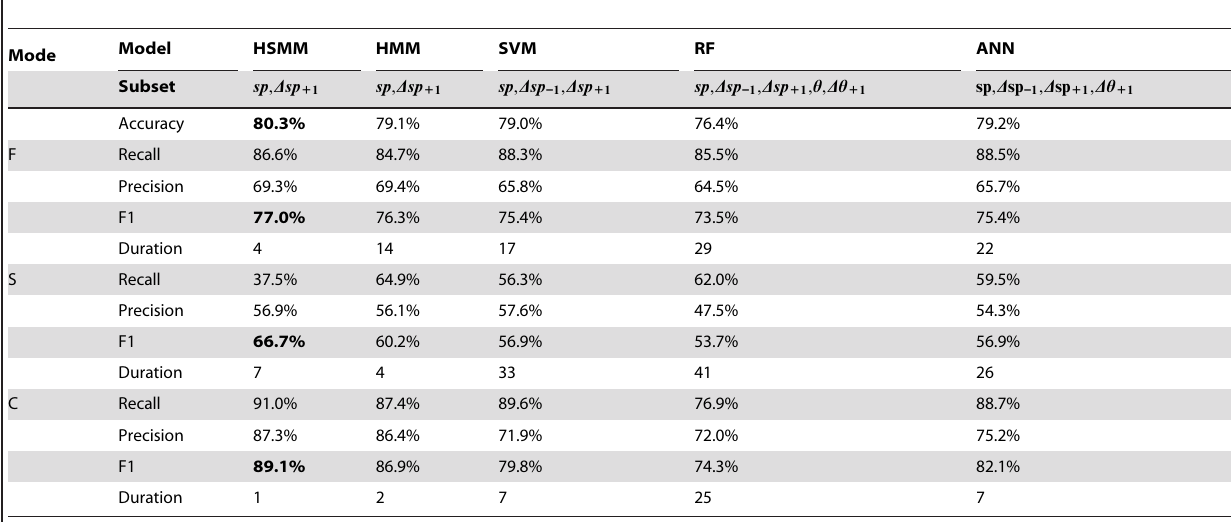
Table 3. Performance of all models for their corresponding best subsets of observed variables.